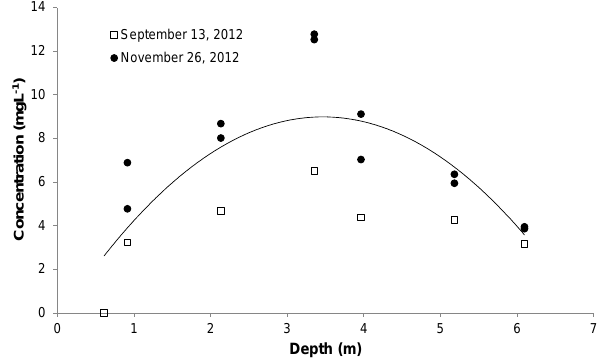
Fig. 6. Plot highlighting fluctuations in hydraulic head from the 6.9m well at the shrub site (i). Fluctuations believed to be an ebul- lition event are outlined by the red box. Daily fluctuations in hy- draulic head are believed to be caused by evapotranspiration. Low reading of 40.36m was recorded when the logger was pulled to download